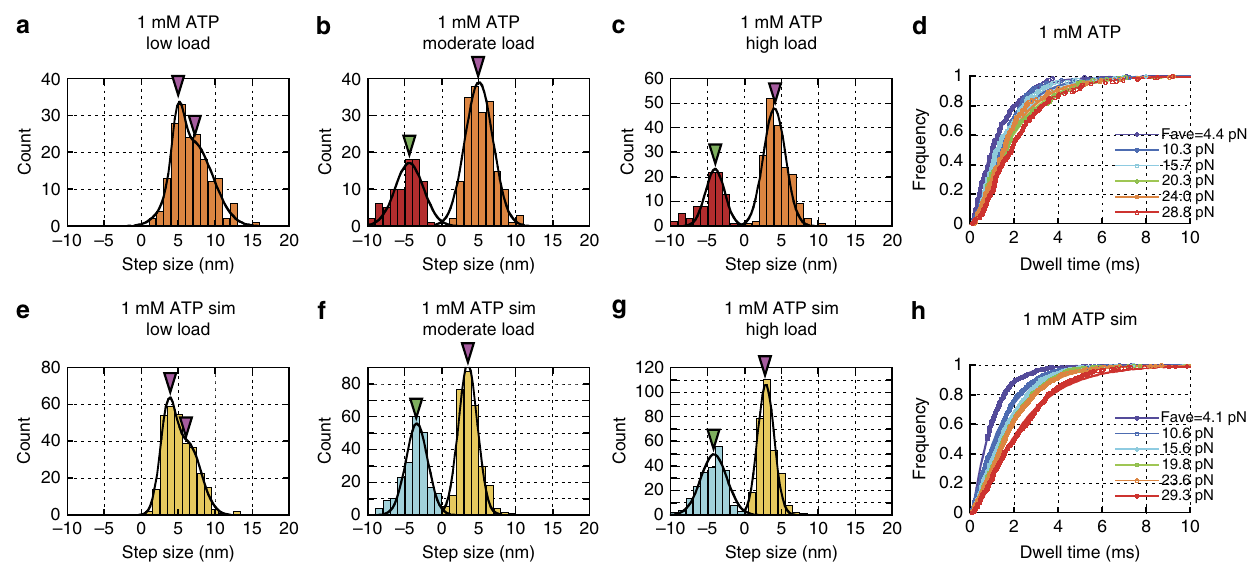
Figure 2 | Step size and dwell time of myosin-rod cofilaments. ( a – c ) Histograms of step sizes experimentally observed at 1mM ATP for low loads (mean of 4.4pN) in a , moderate loads (mean of 15.4pN) in b and high loads (mean of 29.3pN) in c . Also see Supplementary Fig. 2 for other ATP concentrations. ( e – g ) Histograms of step sizes obtained from the simulation model at 1mM ATP for low loads (mean of 4.1pN) in e , moderate loads (mean of 15.3pN) in f and high loads (mean of 30.1pN) in g . Also see Supplementary Fig. 2 for other ATP concentrations. ( d , h ) Cumulative probability distributions of the dwell time fitted to a double exponential function for experimental data in d and simulation data in h . The time constants calculated from double exponential fits were used to calculate mean dwell times as shown in Fig. 3g–i. Arrowheads indicate the peak points of single or double Gaussian functions. Step sizes at the peak were used as the mean step size in Fig.